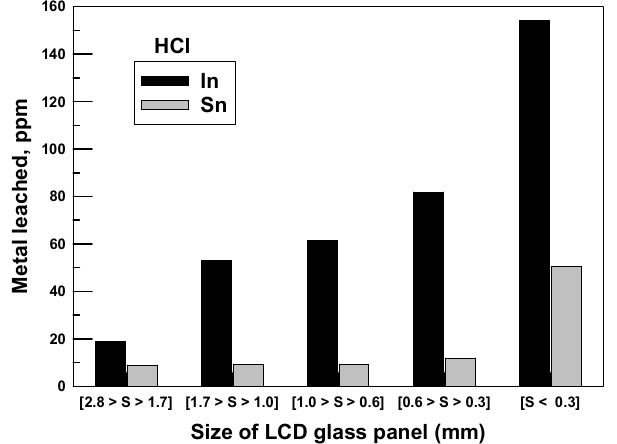
Figure 3. Leaching behavior of indium and tin as a function of the size of the cullet pieces, as classified by sieving using 5 M HCl as the lixiviant (LCD: liquid crystal display).